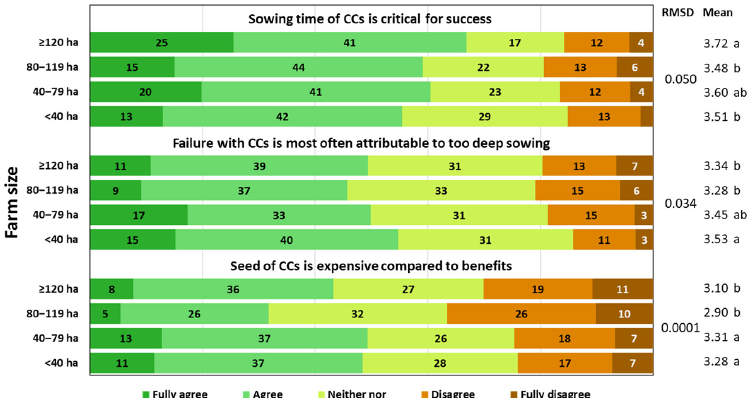
Figure 3. The distribution of farmers’ answers (N = 1130) depending on the farm size (RMSD, row mean scores difference; CCs, cover crops).